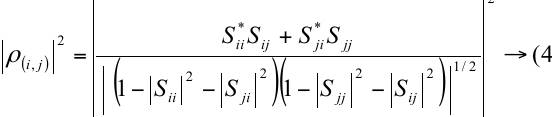
Figure 7: Comparison of simulated and measured Isolation (dB)